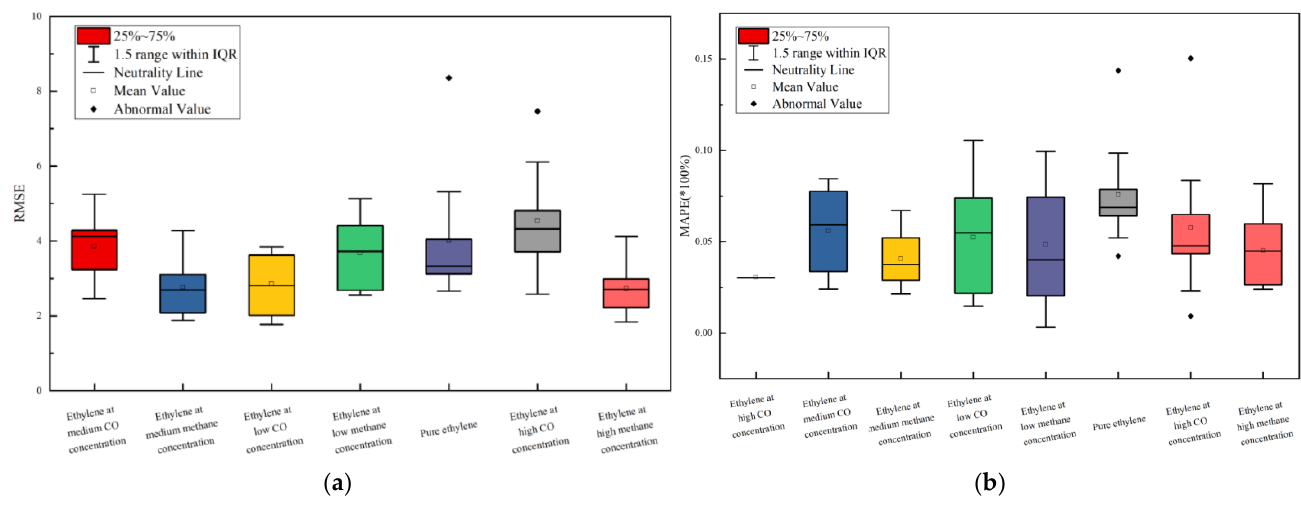
Figure 12. Box plots of ethylene concentration prediction errors under the condition of a high concentration of carbon monoxide as the background gas. ( a ) RMSE; ( b ) MAPE. Table 9. Concentration prediction results for carbon monoxide and methane with ethylene as the background gas.